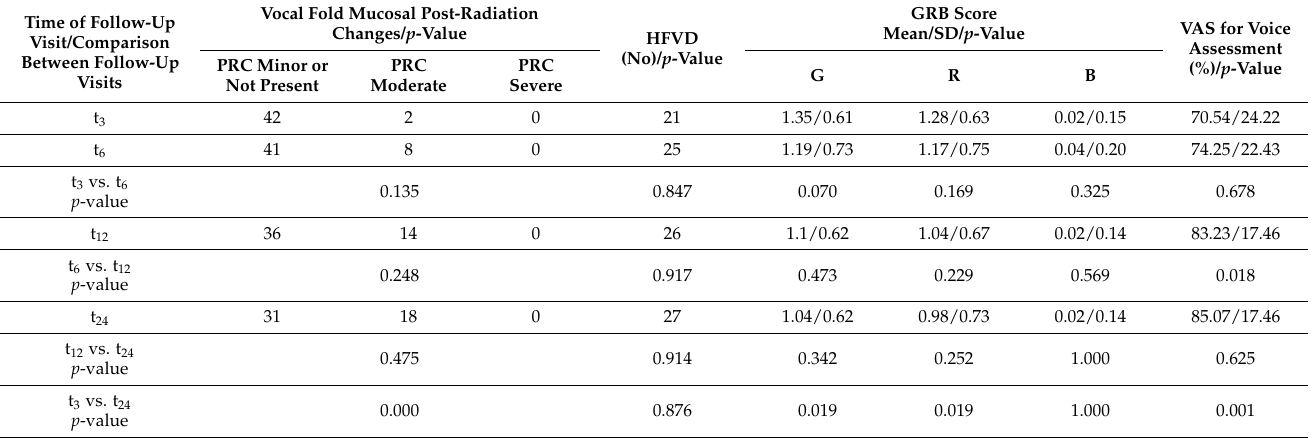
Table 1. Results of videoendostroboscopies and subjective voice assessments over the 24 months after radiotherapy in patients with T 1 glottic carcinomas ( N =